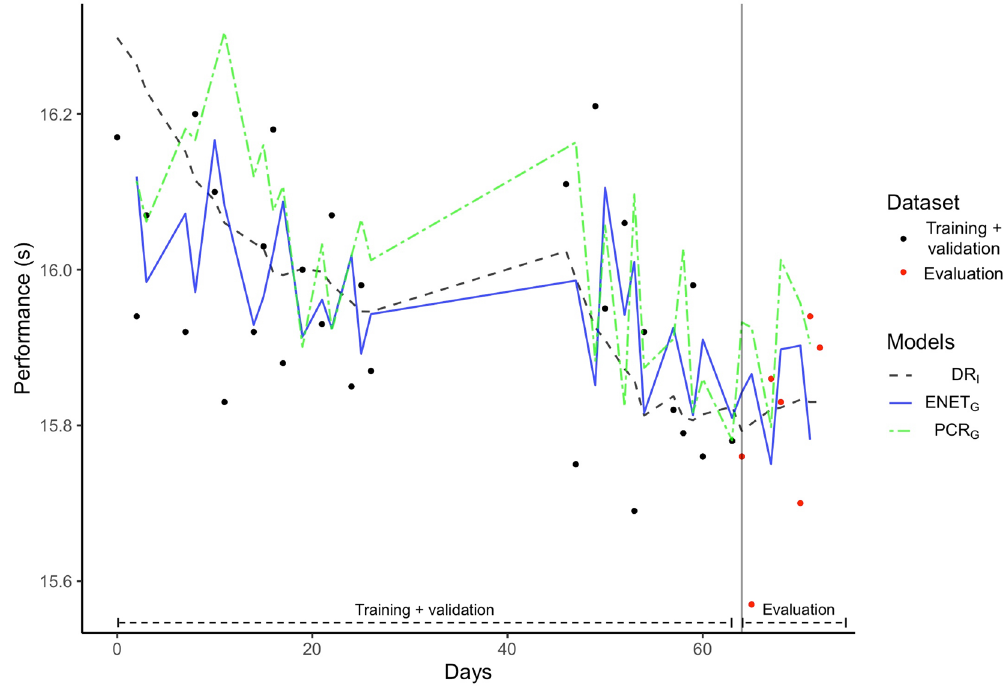
Figure 3. Modelled performance of a representative subject. Solid and dashed lines represent the DR model and the two models offering the best generalisation. On this example, the training data set (80% of the data that combines training and validation subsets) and evaluation data set (20% of the data, the evaluation subset) areas are separated by the vertical solid line. Fitted parameters of the DR model were k 1 = − 2.45 e − 05 , k 3 = − 2.58 e − 09 , τ 1 = 39 , τ 2 = 26 , τ 3 = 5 . Hyper-parameters of the PCR and ENET models were n comp = 3 and α = 0.28 , (cid:31) =